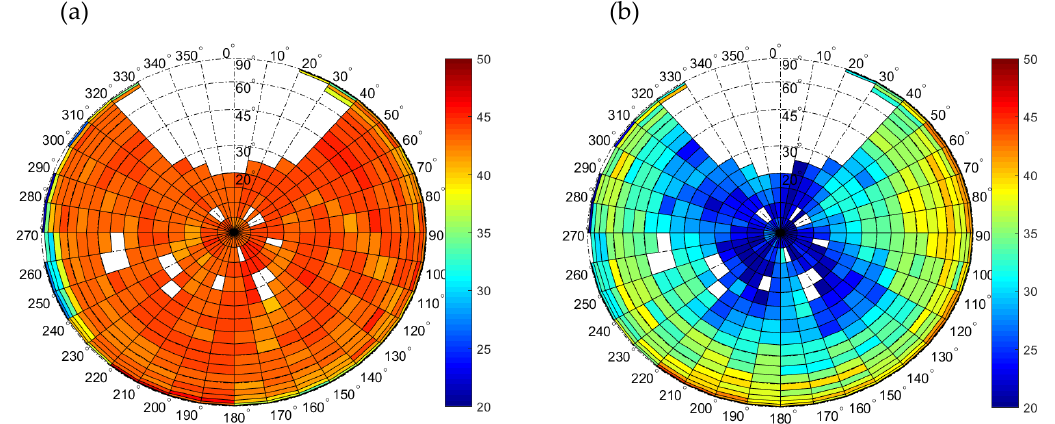
Figure 4. ( a) RHCP and (b) LHCP average received carrier-to-noise ratio (C/N 0 ) for June 7th